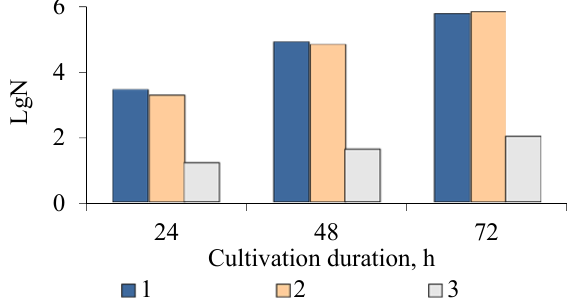
Fig. 4. Dynamics of the number of Bifidobacterium adolescentis MC 42 (lgN) cells in the nutrient medium that contains cedar oil (10.0% emulsion in water) after 24 h, 48 h and 72 h of fermentation: (1) oil (cold pressing); (2) oil (heat pressing); (3) control (a culture medium that does not contain any potential antioxidant agents). The data are expressed as a mean ± standard deviation ( n =